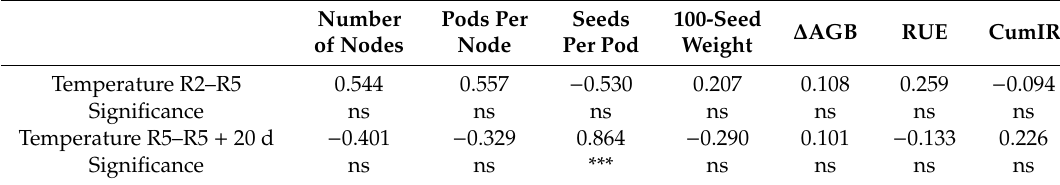
Table 6. Partial correlation coe ffi cients, when mean fraction of available soil water is held constant, for the relationships between mean temperature during the reproductive stage (from R2 to R5 and from R5 to R5 + 20 days) and yield components (numbers of nodes, pods per node, and seeds per pod, and 100-seed weight), change in aboveground biomass ( ∆ AGB), cumulative intercepted irradiation (CumIR), and radiation use e ffi ciency for dry matter production (RUE) across three soybean cultivars and two sowing dates in 2015 and 2016 ( n = 12) in the Tohoku region of northern Japan. Number Pods Per Seeds 100-Seed ∆ AGB RUE CumIR of Nodes Node Per Pod Weight Temperature R2–R5 0.544 0.557 − 0.530 0.207 0.108 0.259 − 0.094 Significance ns ns ns ns ns ns